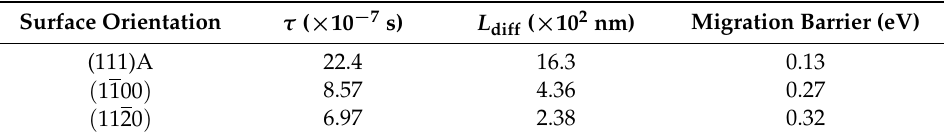
Table 3. Values of τ and L diff obtained by MC simulations, and migration barriers of In adatom on bare (111)A, ( 1100 ) , and ( 1120 ) surfaces using Figures 23 and 29. Here, we assume that temperature and In pressure are 600 ◦ C and 3.3 × 10 − 3 Torr, respectively. The lowest values for migration barriers are taken on each